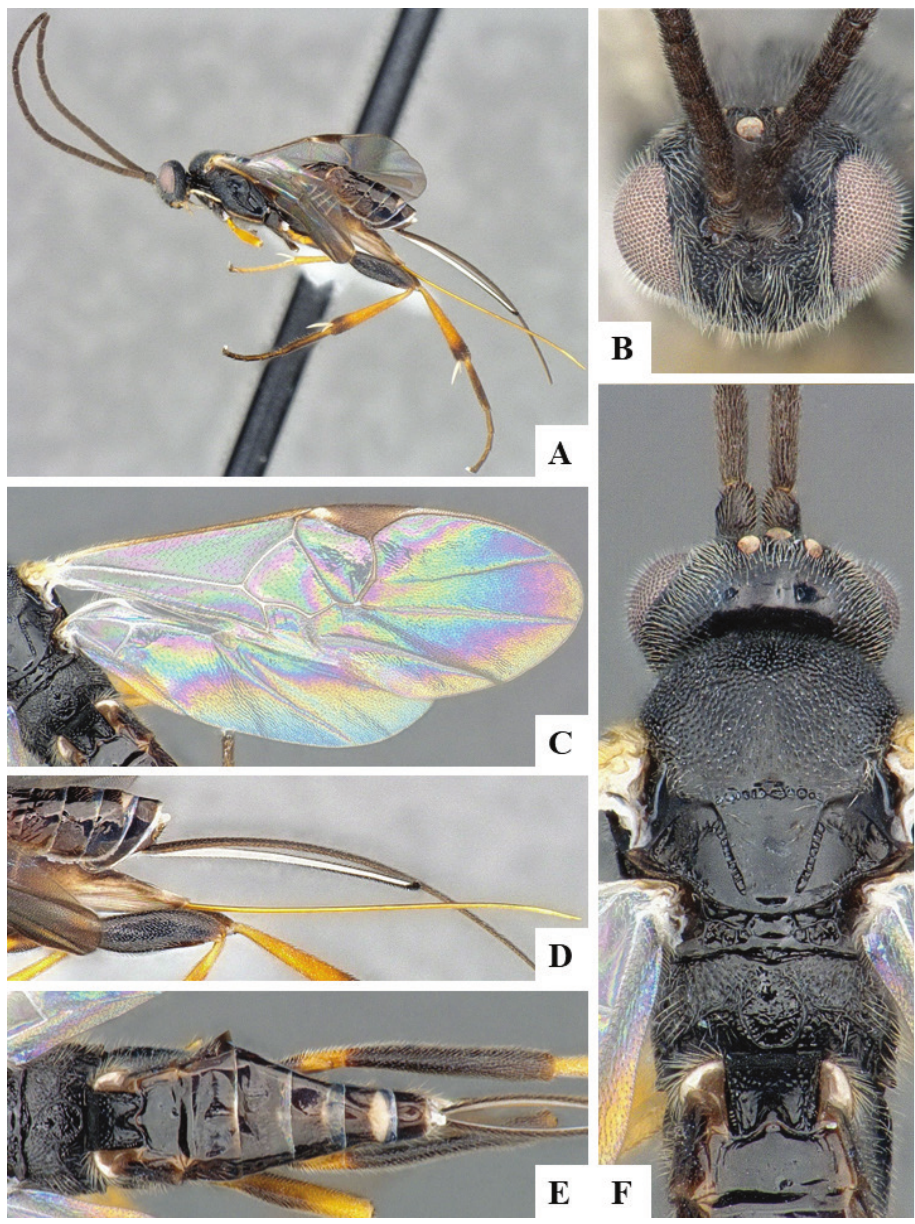
Figure 7. A–F Dolichogenidea rogerblancoi sp. n., holotype. A habitus, lateral B head, frontal C wings; D metasoma, lateral E metasoma, dorsal F head and mesosoma,